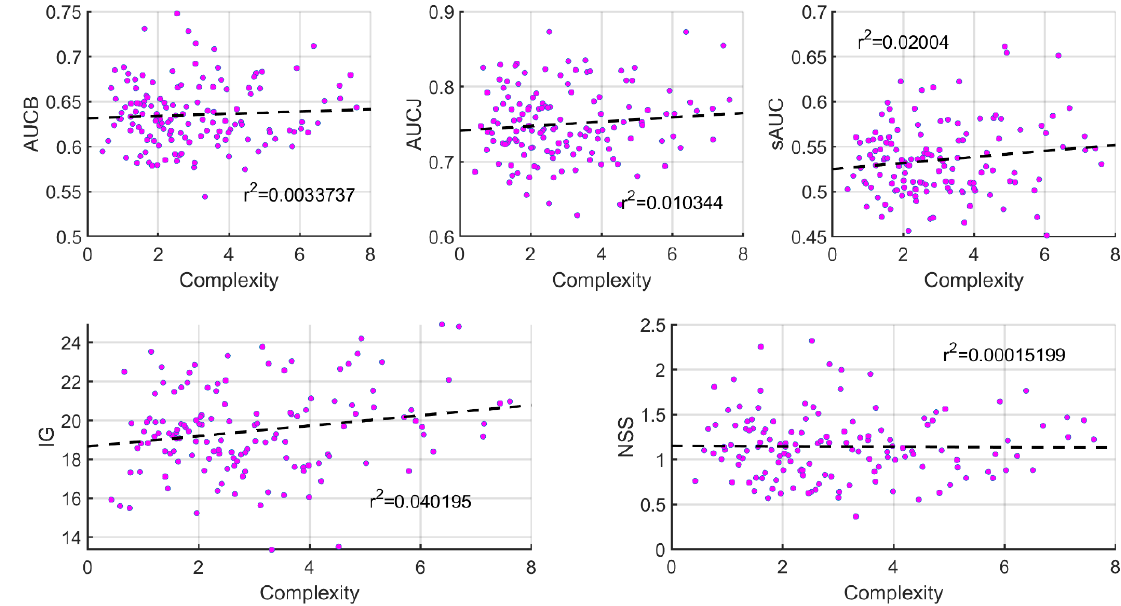
Figure 7. Correlation plots comparing heat map comparison metrics with the Complexity metric for the inter-observer free-viewing case. Linear fits are shown as dashed lines, and the r 2 correlation coefficients are shown as insets.